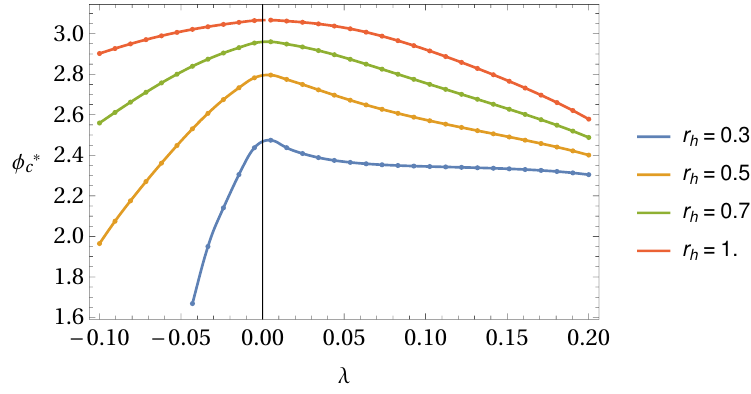
Figure 8. Critical values (cid:30) (cid:3) , de(cid:12)ned such that for (cid:30) A > (cid:30) (cid:3) the causal wedge displays holes (and C C the causal information surface is disconneted), for several values of the black hole horizon radius, as a function of the Gauss-Bonnet coupling (cid:21)